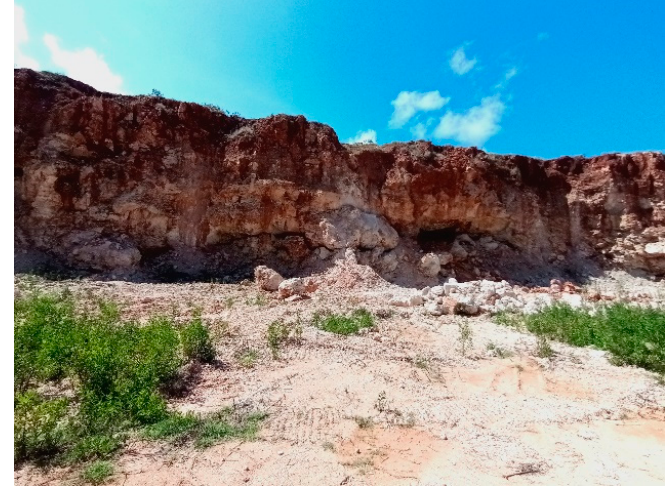
Figure 6. Near ‐ vertical slopes from excavation. Figure 6. Near-vertical slopes from